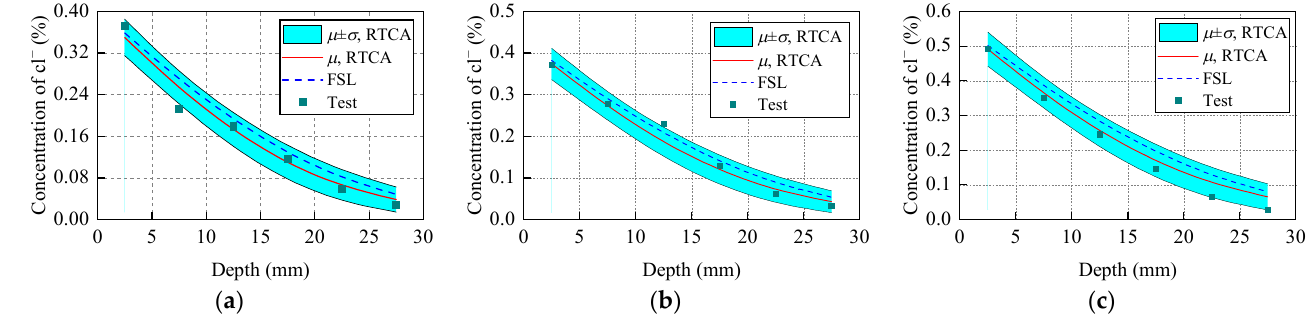
Figure 14. Comparison between the statistical results of the 3D RTCA model and the experimental data and Fick’s second law analytical solution: ( a ) w / c = 0.35, ( b ) w / c = 0.4, ( c ) w / c = 0.45.